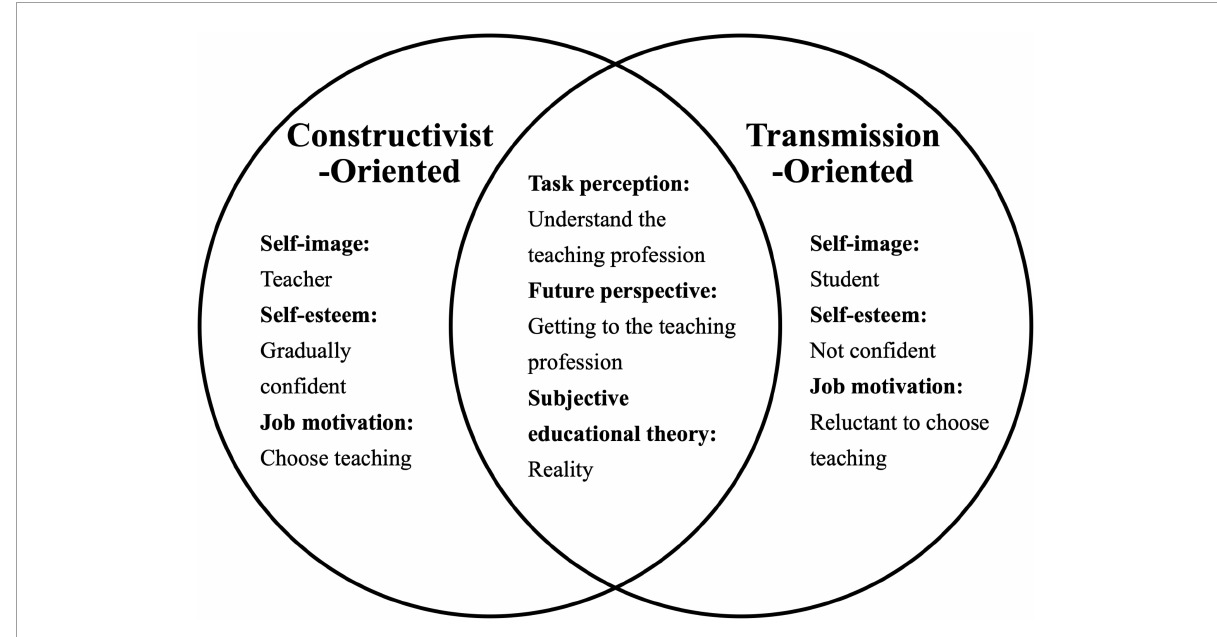
FIGURE1 The impact of mentoring on student–teacher